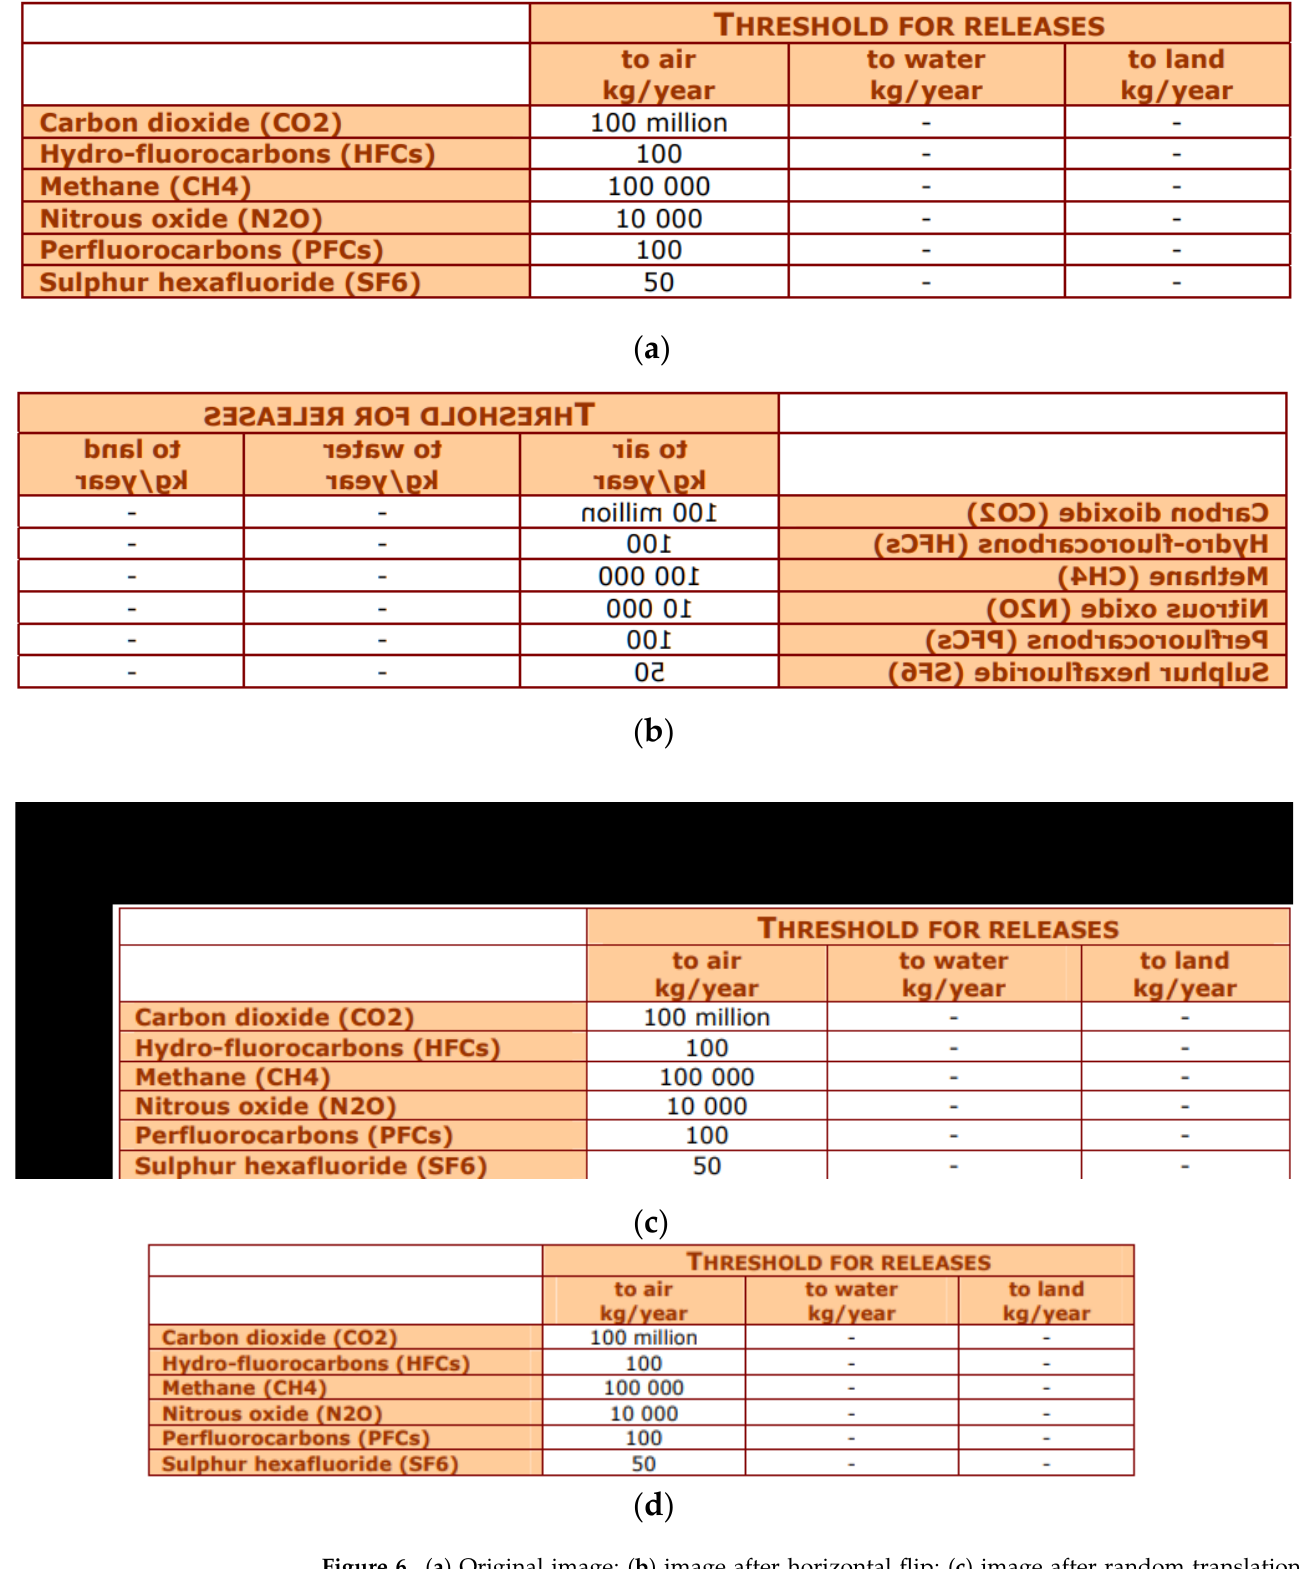
Figure 6. ( a ) Original image; ( b ) image after horizontal flip; ( c ) image after random translation; ( d ) image after random scaling .